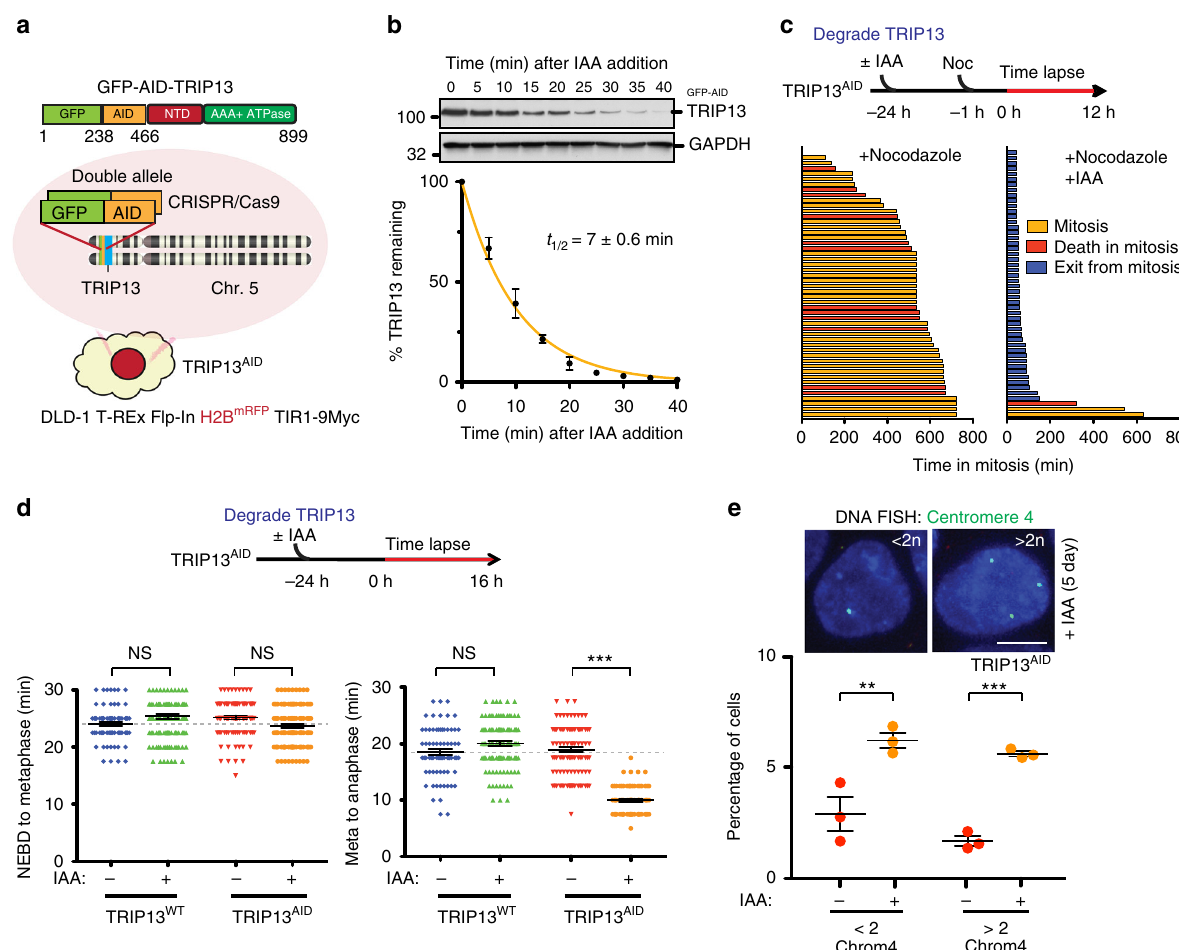
Fig. 1 Abrupt TRIP13 depletion compromises mitotic checkpoint activation. a Schematic illustration of CRISPR-Cas9 mediated genome editing of DLD-1 T- REx Flp-In H2B mRFP + TIR1-9Myc + human colon cancer cell line to tag both endogenous TRIP13 alleles with green fl uorescent protein (GFP) and an auxin- inducible degron (AID). b Upper: Indole-3-acetic acid (IAA) was added to engineered TRIP13 AID cells and level of GFP-AID-TRIP13 was measured by quantitative immunoblot analysis. Lower: Degradation kinetics of GFP-AID-TRIP13 from triplicate measurements, fi t using a single-exponential decay function (yellow line). c TRIP13 function in mitotic checkpoint. Upper: Schematic of experiment to test the role of TRIP13 in mitotic checkpoint activation. Lower: Timing of mitotic exit and cell fate as measured by time-lapse live-cell imaging. ( n = 57 for + Nocodazole, n = 54 for + Nocodazole, + IAA). d TRIP13 function in unperturbed mitosis. Upper: Schematic of experiment to test the contribution of TRIP13 in mitotic checkpoint activation. Lower: For each cell, timing of nuclear envelope breakdown (NEBD) to metaphase (left panel) and metaphase-to-anaphase (right panel) were measured. Cells monitored: n = 78, 137, 100, 120, 79, 129, 102, 81. e Upper: Representative images of TRIP13 AID cells treated with IAA for 5 days and probed by FISH for the centromere of chromosome 4. Lower: Percentage of cells with the indicated number of chromosome 4 centromere foci after 5-day IAA treatment. Total cells counted: 1156 for control, 1119 for IAA treatment over three separate experiments. Scale bar, 5 μ m. P -values for d and e were calculated using an unpaired two-tailed t-test (** P < 0.01, *** P < 0.001, NS not signi fi cant). Lines in b , d , and e represent the mean ±